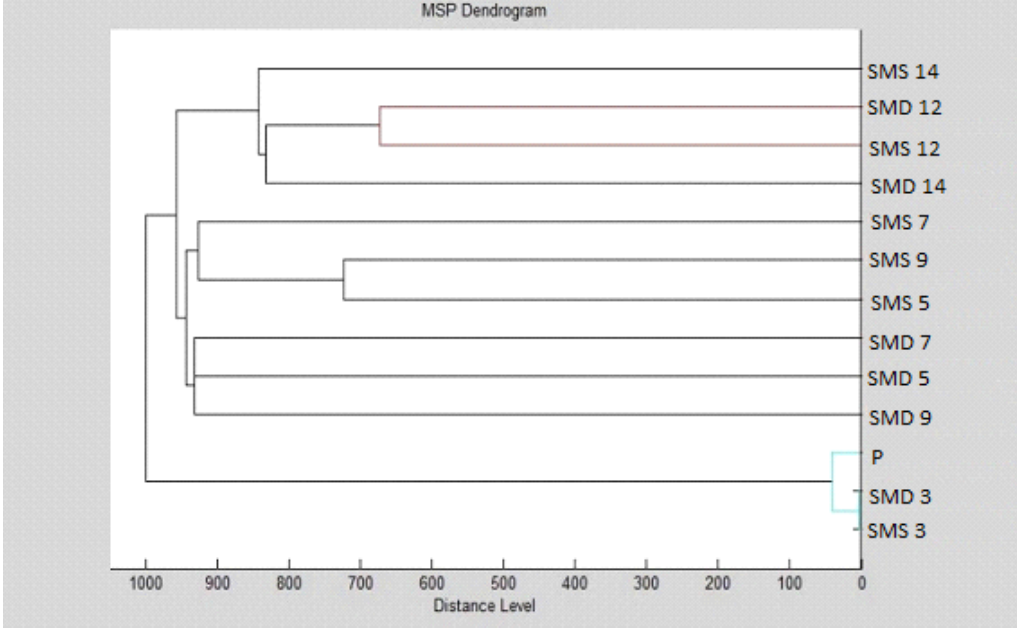
Figure 4. Dendrogram of S . maltophilia with MSP for planktonic cells and all experimental groups: SM- Stenotrophomonas maltophilia ; S-glass; D-wood; P-planktonic cells. MSP grouping of S. maltophilia for planktonic cells and all experimental groups showed that the young P, SMD 3 and SMS 3 biofilms were the most distant group, while the biofilm formation profile of S. maltophilia was balanced in the grouping manner (Figure